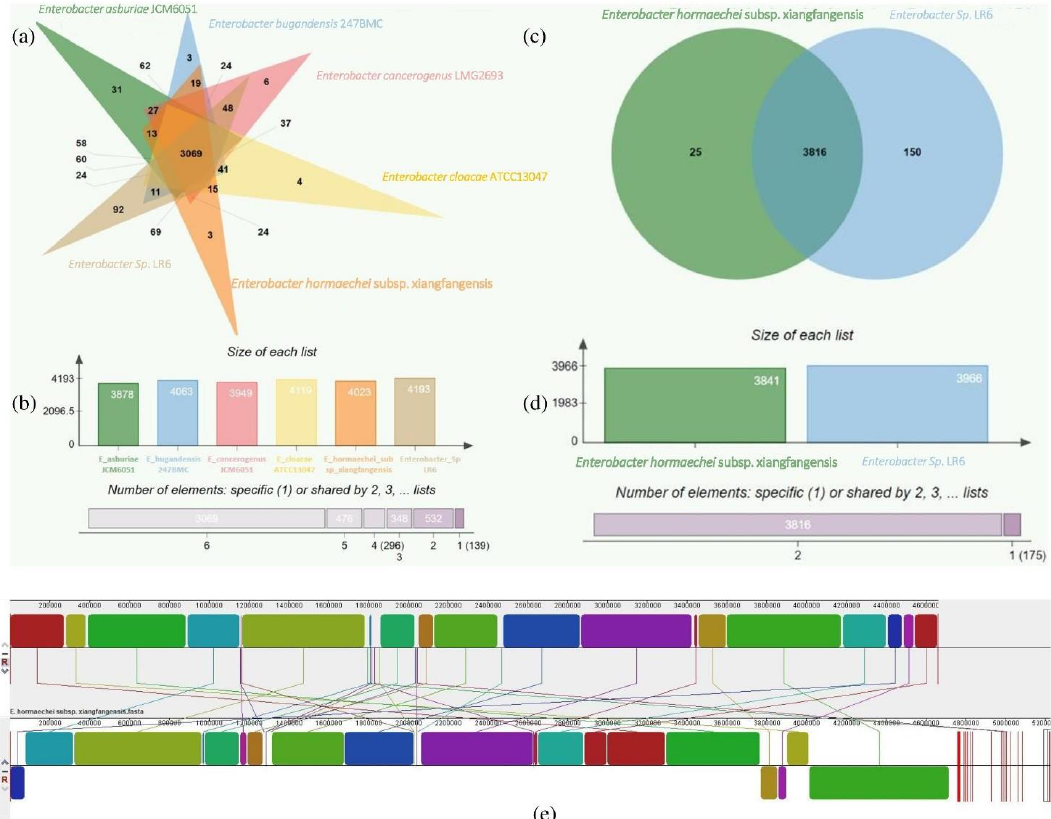
Figure 3. Venn diagram representing the distribution of unique and shared proteins among Enterobacter sp. LR6 and closely related genomes ( a ); the bar plot below the Venn diagram shows the number of proteins found in each species ( b ). Distribution of Enterobacter sp. LR6 proteins with the closest strain E. hormaechei subsp. Xiangfangensis genome ( c ); the bar plot shows the number of proteins found in Enterobacter sp. LR6 and E. hormaechei subsp. Xiangfangensis ( d ). Genome alignment of Enterobacter sp. LR6 and E. hormaechei subsp. Xiangfangensis genome constructed using MAUVE showing the genome-wide variation. The local collinear blocks (LCBs) in different colors represent conserved segment, white areas within LCBs represent regions with low similarity, and the scale represents the coordinates of each genome. The LCBs present above and below the central black horizontal line are the forward and reverse orientation, respectively. The rearrangement between the two genomes is represented by the colored lines ( e ).